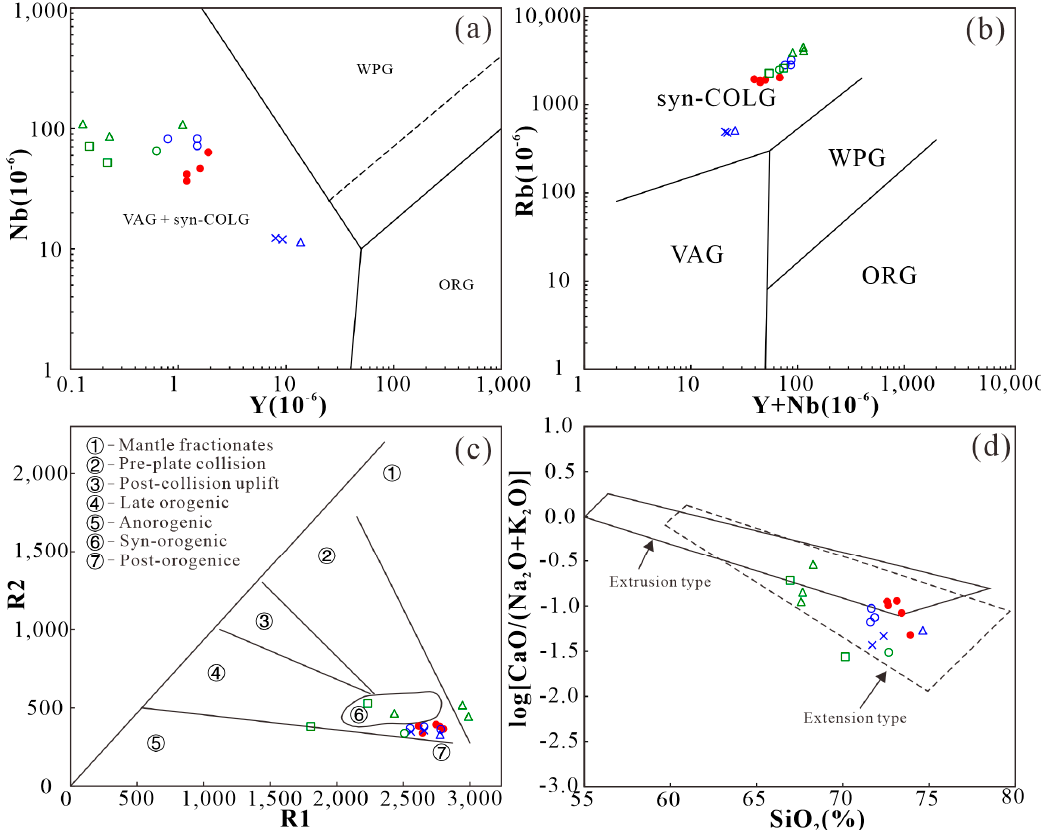
Figure 8. The tectonic discrimination diagrams of the Dongcao muscovite granite: ( a ). Nb vs. Y discrimination diagram (the base map is derived from [72]); ( b ). Rb vs. (Y + Nb) discrimination diagram (the base map is derived from [72]); ( c ). R2 vs. R1 discrimination diagram (the base map is derived from [73]); ( d ). log [CaO/(Na 2 O + K 2 O)] vs. SiO 2 discrimination diagram (the base map is derived from [74]). (Legend description: ORG: ocean ridge granites; WPG: granites within the plate; VAG: volcanic arc granites; Syn–COLG: syn–collisional granites. The red dots are data of the Dongcao muscovite granite samples in this paper; the blue crosses are data of the Dagang protolothionite muscovite granite; the blue triangles are data of the Dagang pegmatitic dike; and the blue circles are data of the Dagang lepidolite alkali–feldspar granite [8]; the green circles are data of the Baishuidong Li–rich muscovite granite; the green rectangles are data of the Baishuidong trilithionite granite; and the green triangles are data of the Baishuidong aplite